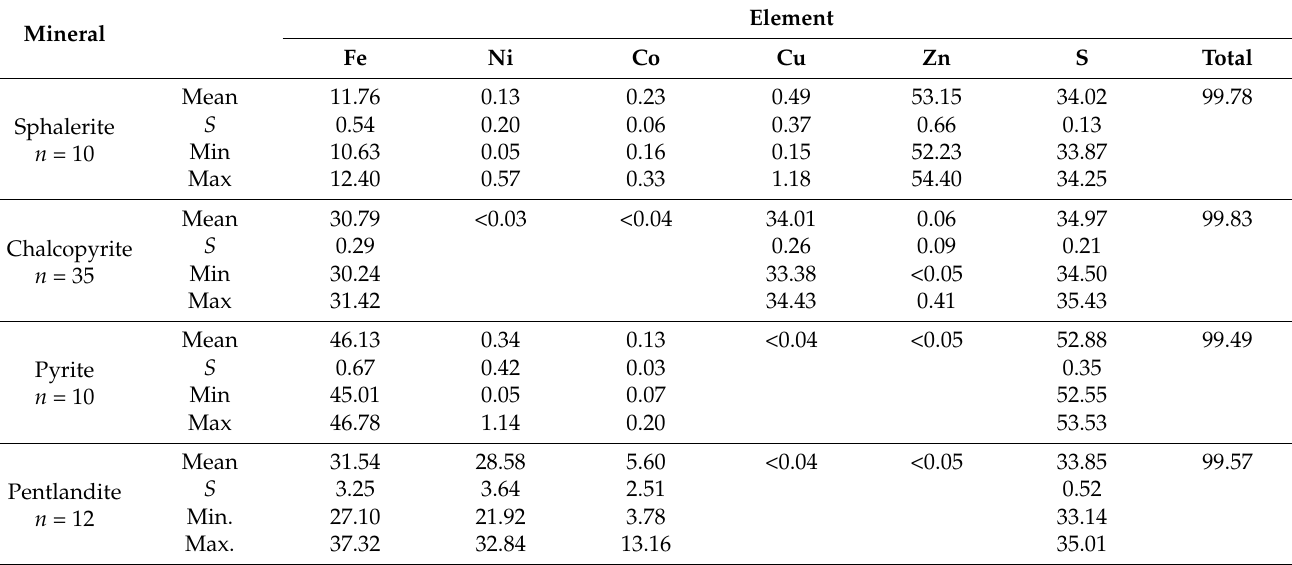
Table 7. Average compositions of sphalerite, chalcopyrite, pyrite, and pentlandite from gabbro of the Kochumdek trap roof (EPMA data, wt%).